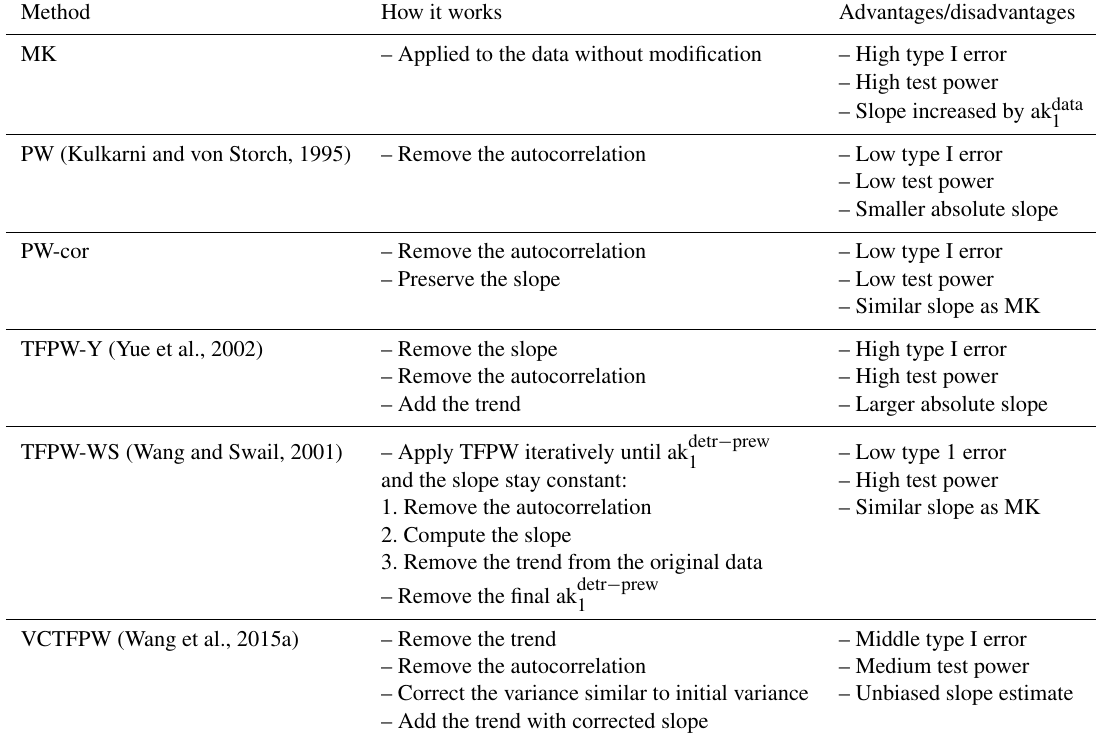
Table 1. Advantages and disadvantages of the MK test and of the various prewhitening